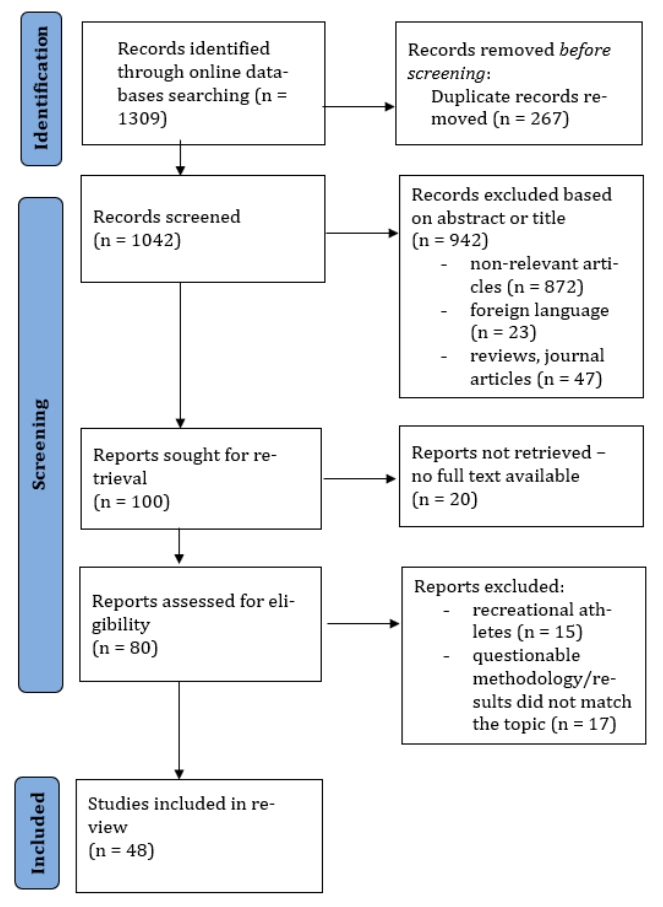
Figure 1. Flow chart diagram of the study